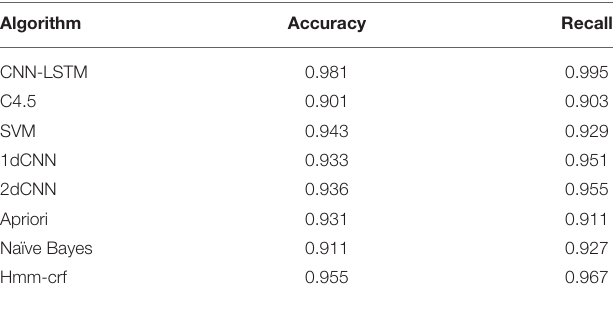
TABLE 5 | Comparison of classification performance with other traffic classification algorithms on Datasets ISCX.